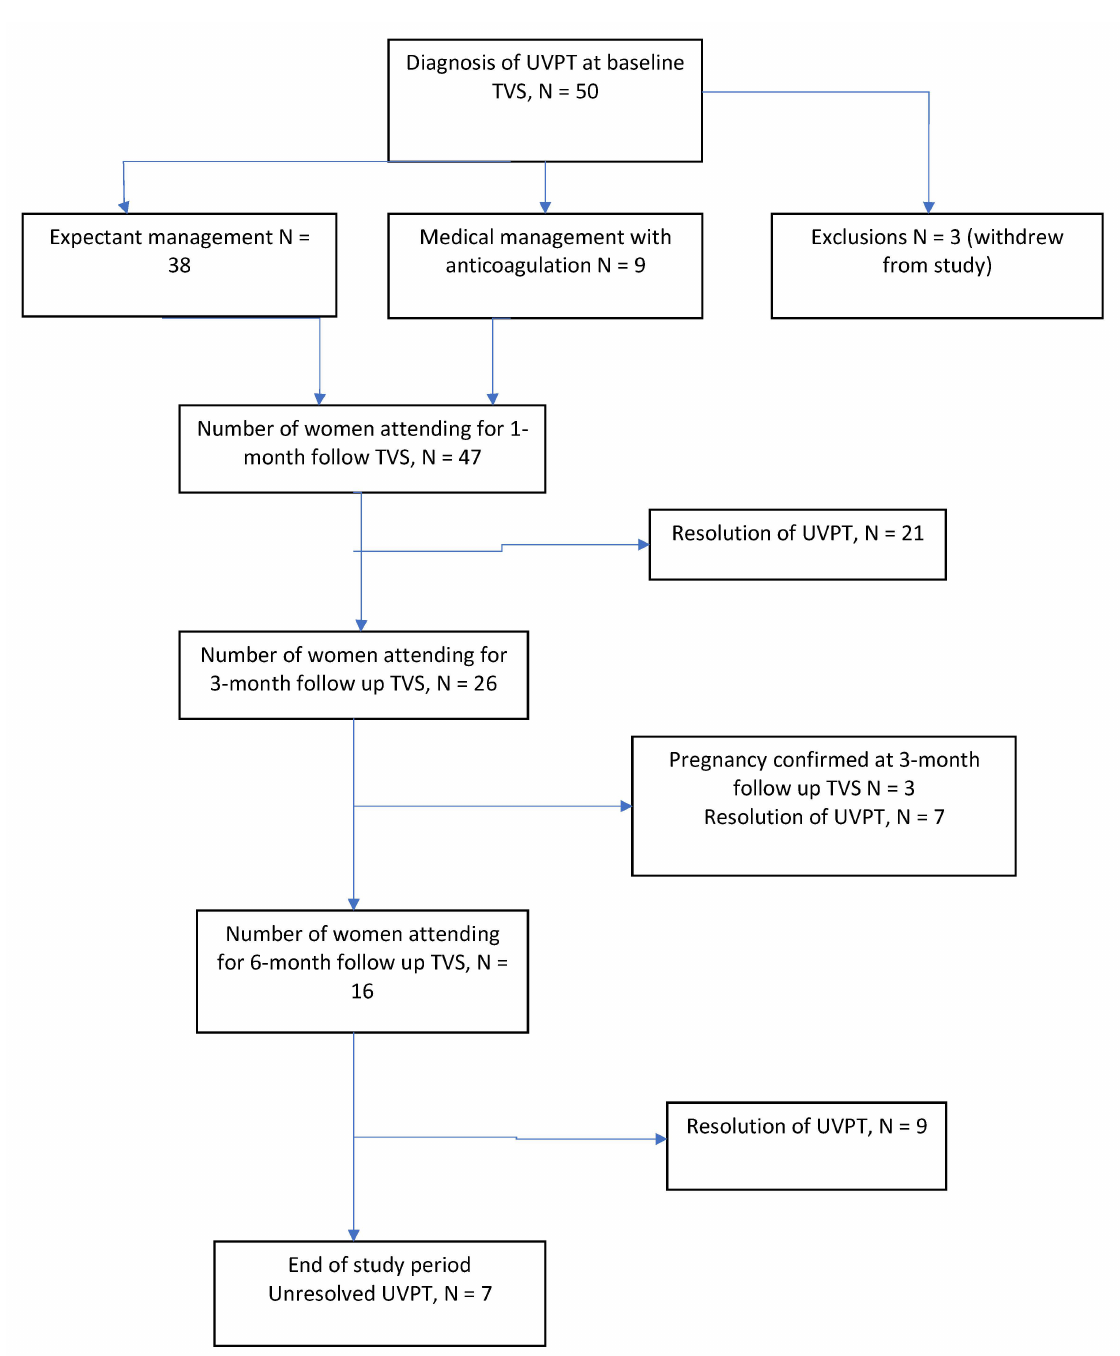
Figure 4. Flow chart of study